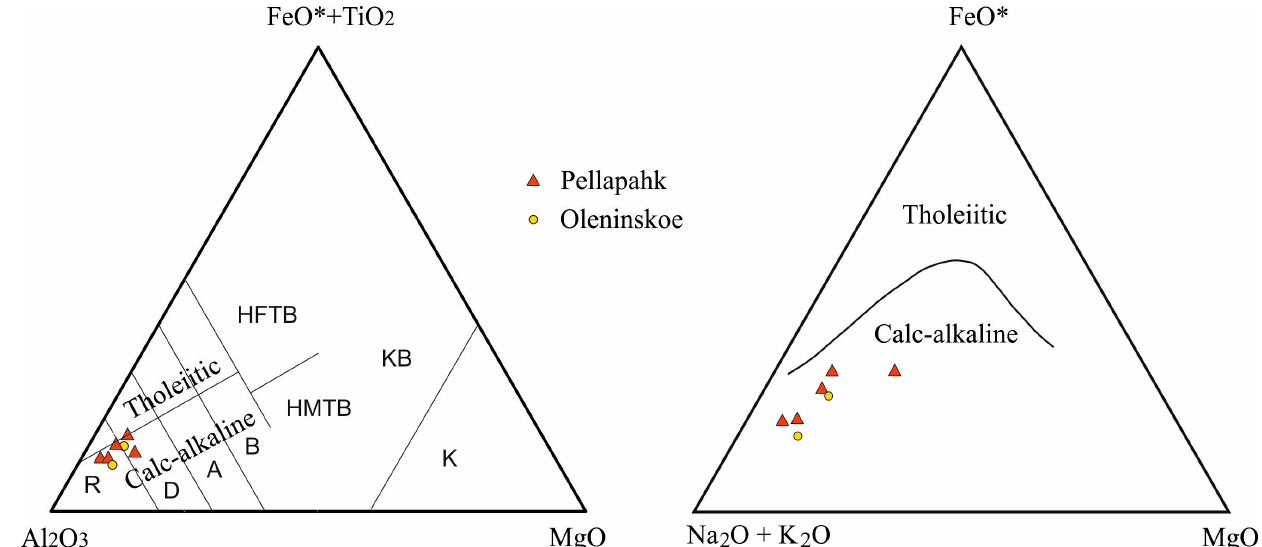
Figure 5. Composition of the Pellapahk and Oleninskoe granite-porphyry in the petrochemical diagrams (FeO* = FeO + O.9*Fe 2 O 3 ). REE spectra (Figure 6), drawn with data from Tables 2 and 5, are similar to the REE spectrum of I-type granite, formed under conditions of subduction and island arc [34].